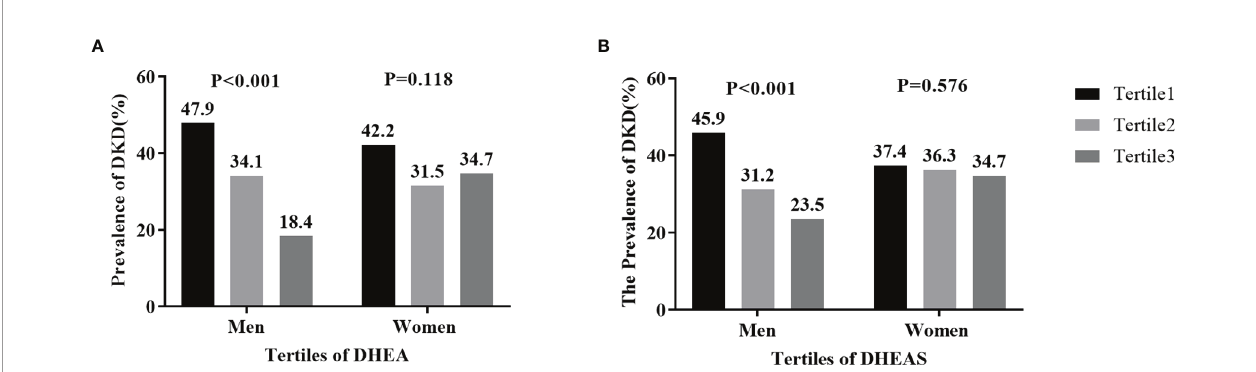
FIGURE 3 | Prevalence of diabetic kidney disease (DKD) by tertiles of serum dehydroepiandrosterone (DHEA) and dehydroepiandrosterone sulfate (DHEAS) in men and women: (A) DHEA; (B) DHEAS. Figure 3 shows that the percentages of men with DKD signi fi cantly decreased in accordance with increasing tertiles of serum DHEA and DHEAS (both P